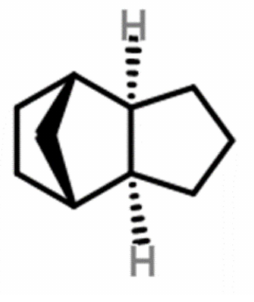
Figure 1. The molecular structure of JP-10.